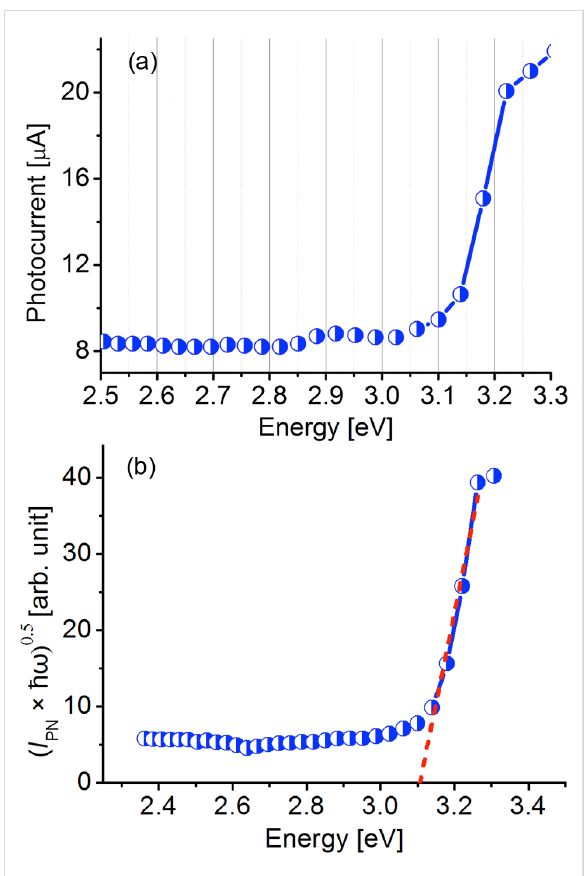
Figure 5: (a) The photoconductivity spectral response from a single upright standing ZnO NR recorded using a 150 W Xe lamp connected to the monochromator. The sample bias was − 10 V. (b) The quantum efficiency of light conversion linearized in coordinates versus . The dashed line represents extrapolation of the linearized region until the intersection with the